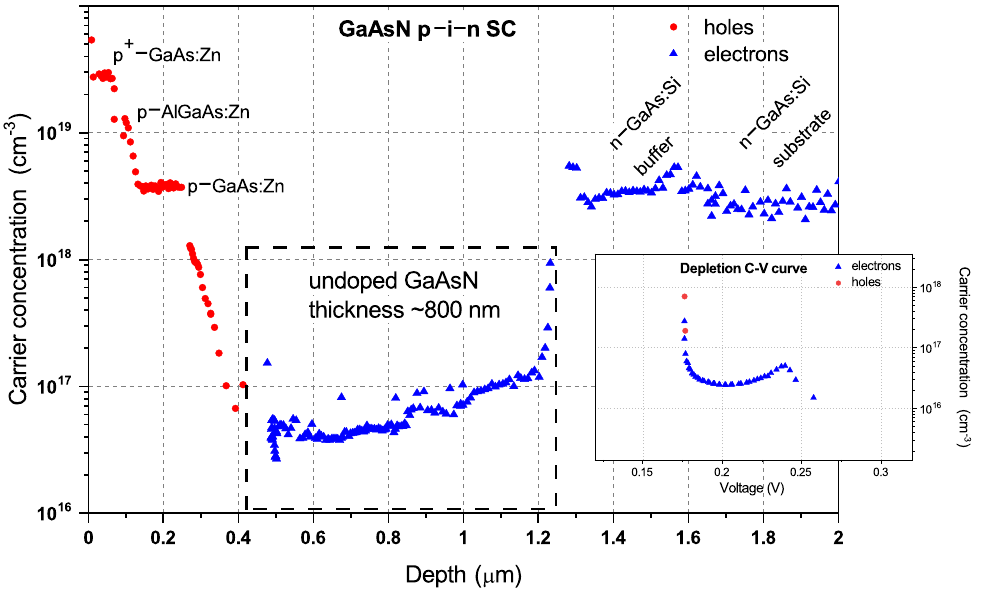
Figure 2. Free carrier concentration distribution across GaAsN p-i-n solar cell